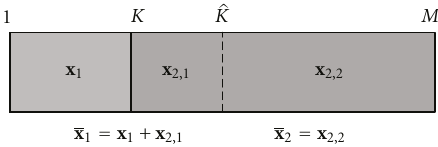
Figure 1: Situation with real K and estimated (cid:13) K